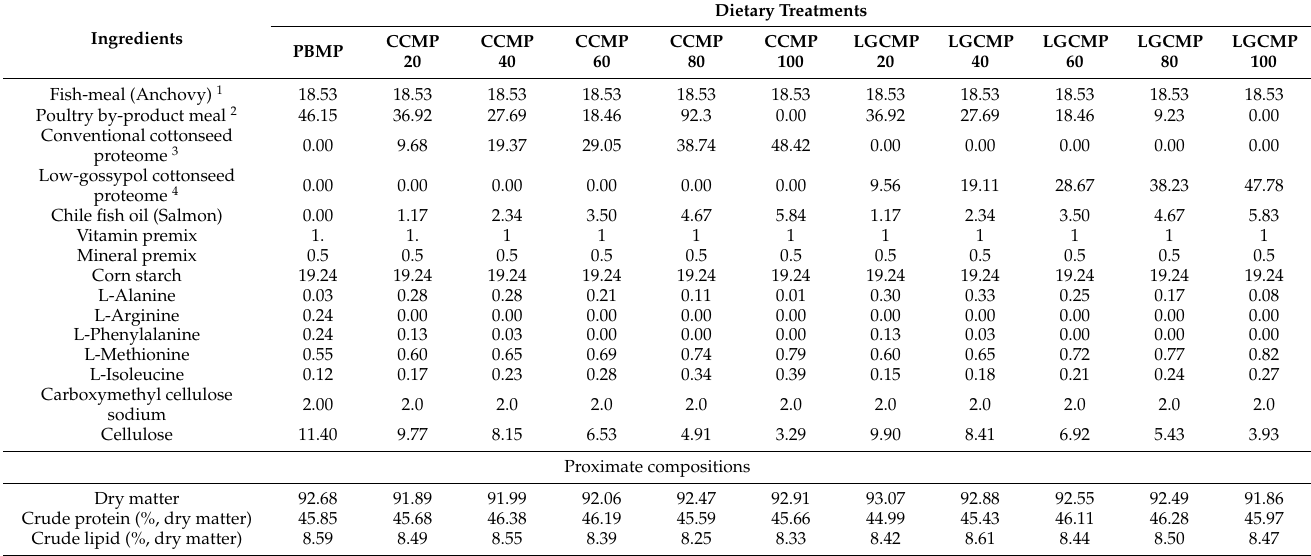
Table 1. Formulations (dry matter basis, %) and analyzed compositions of experimental diets.